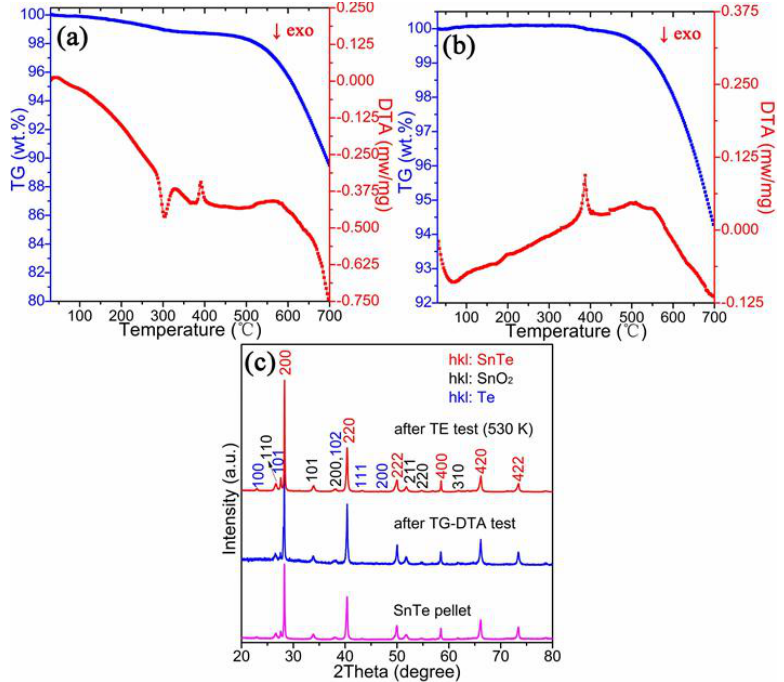
Figure 5. ( a , b ) TG-DTA profiles of the SnTe powder and pellet, respectively; ( c ) PXD patterns of an SnTe pellet before and after TG-DTA (to 973 K) and thermoelectric property testing (to 530 K).